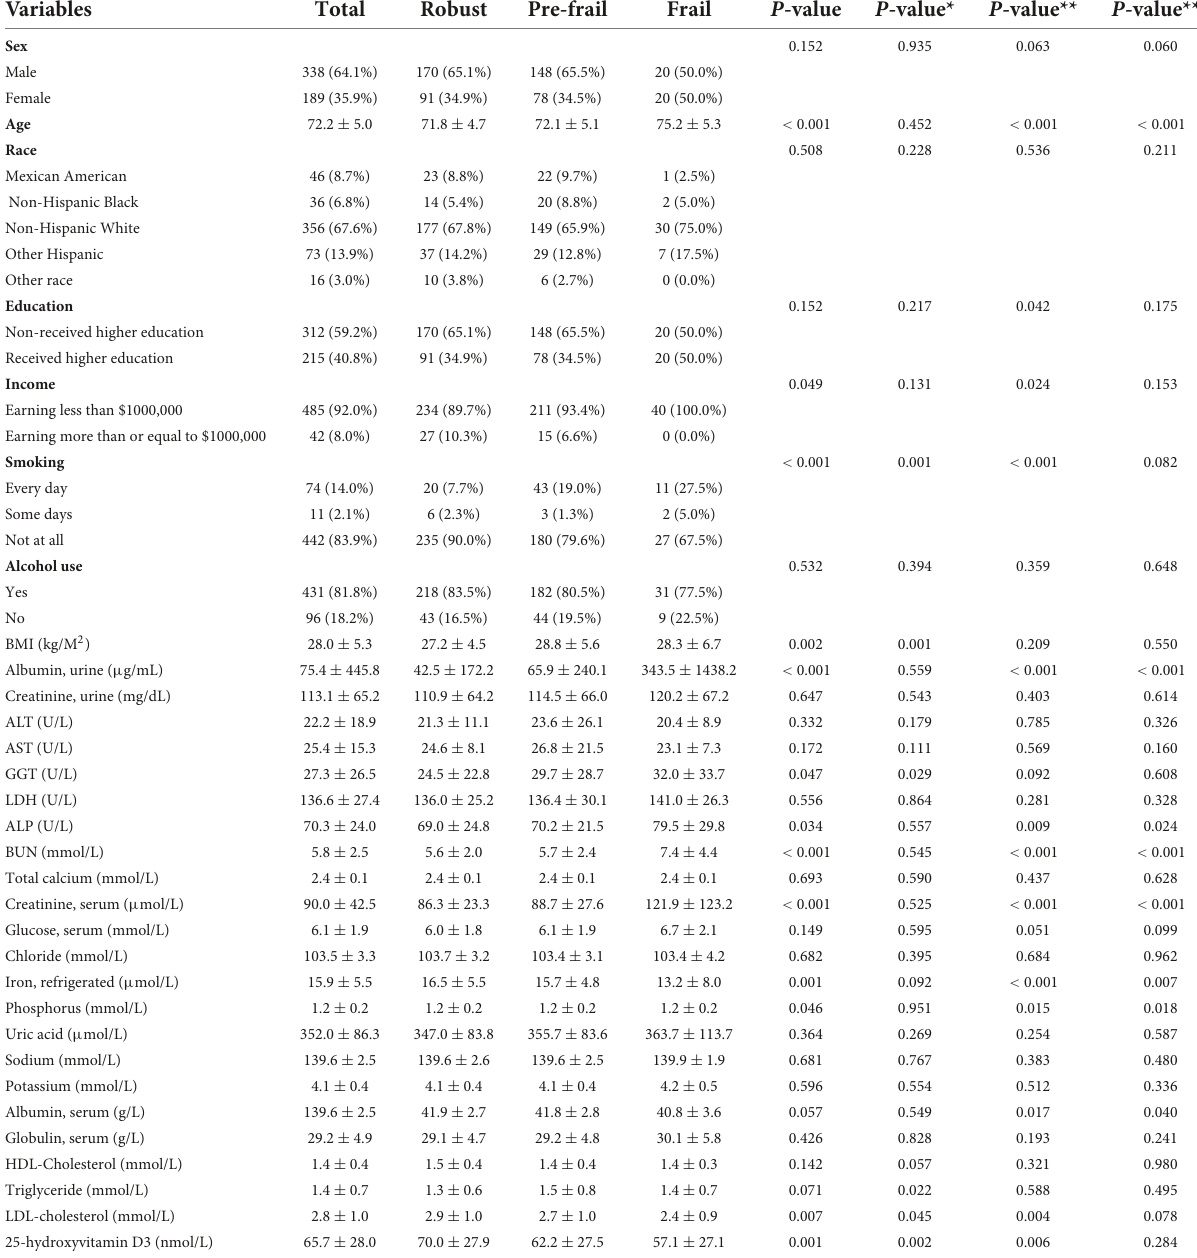
TABLE 1 Candidate variables and baseline characteristics of the